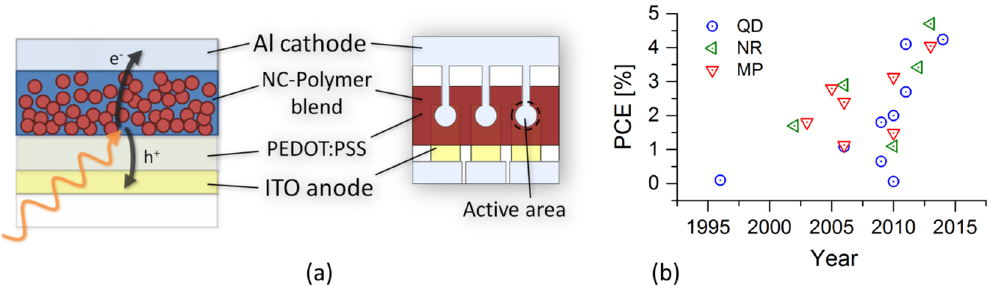
Figure 1. ( a ) Working principle and device structure shown on the cross-sectional and on the top view of the investigated hybrid bulk heterojunction (BHJ) solar cell with the active area size of 0.07 cm 2 . ( b ) Power conversion efficiencies of selected hybrid BHJ solar cells published over the years from nanocrystals (NCs) of different shape: quantum dots (QD) [2,3,6–12], nanorods (NR) [5,10,13–15], multipods (MP) [4,10,16–19,20].